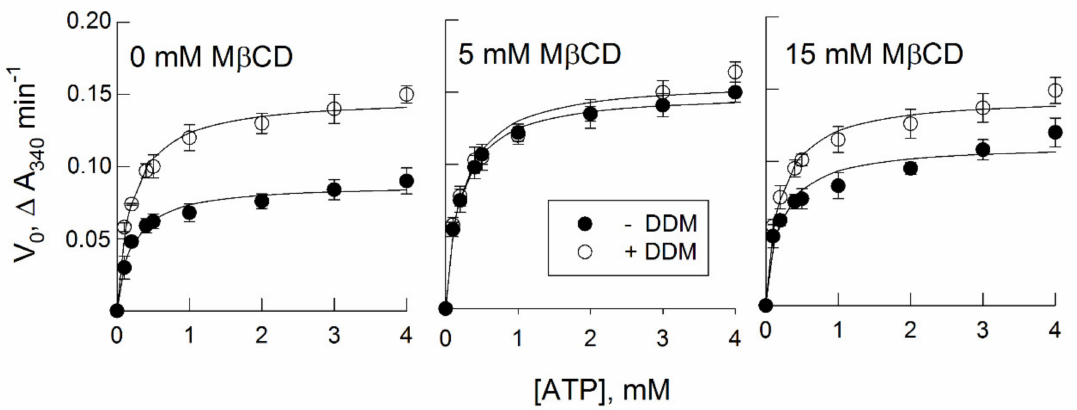
Figure 5. Hydrolysis of ATP by plasma membrane vesicles with different sterol contents in the presence or absence of dodecyl maltoside (DDM). Sterols were extracted by treatment of plasma membranes in the presence of different M β CD concentrations, and then, vesicles were washed from sterols/M β CD complexes by centrifugation. The initial velocities ( V 0 ) represent means ± SD. Values of K M and V max are presented in Table